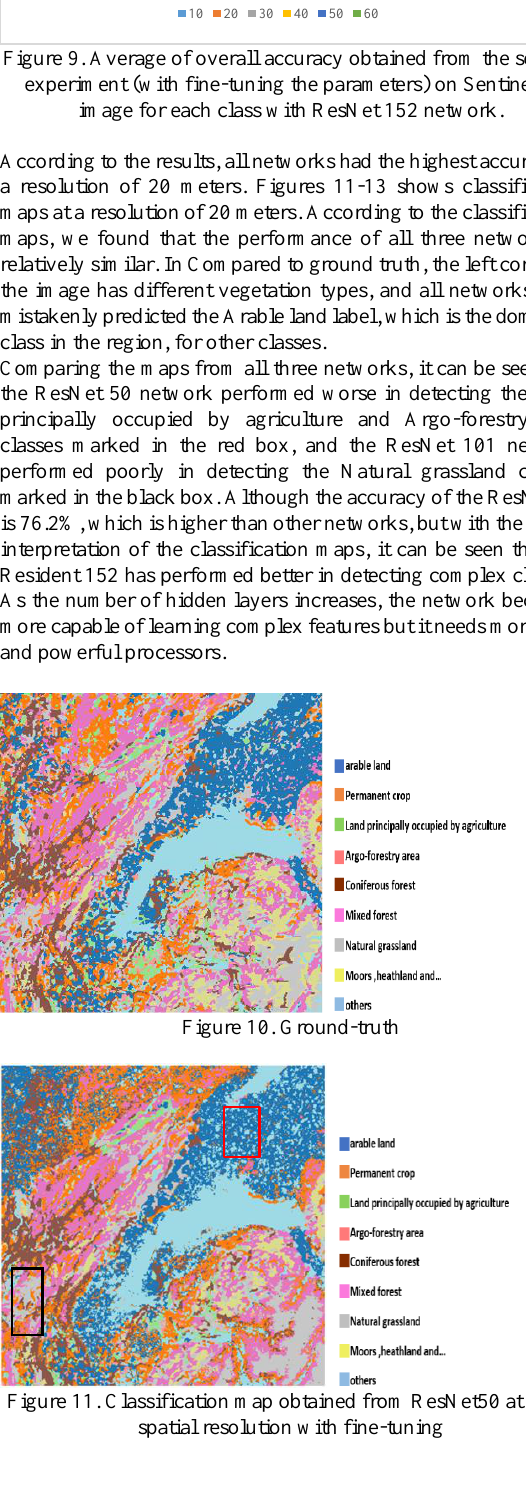
Figure 11. Classification map obtained from ResNet50 at 20 m spatial resolution with fine-tuning